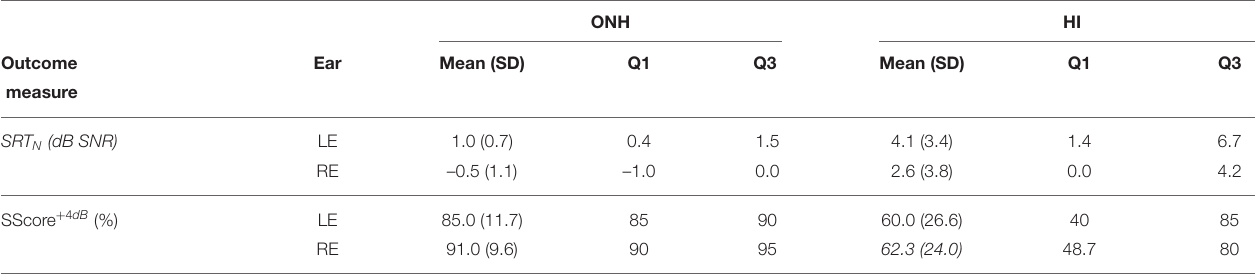
TABLE 7 | Summary of the results of the hearing in noise test (HINT).